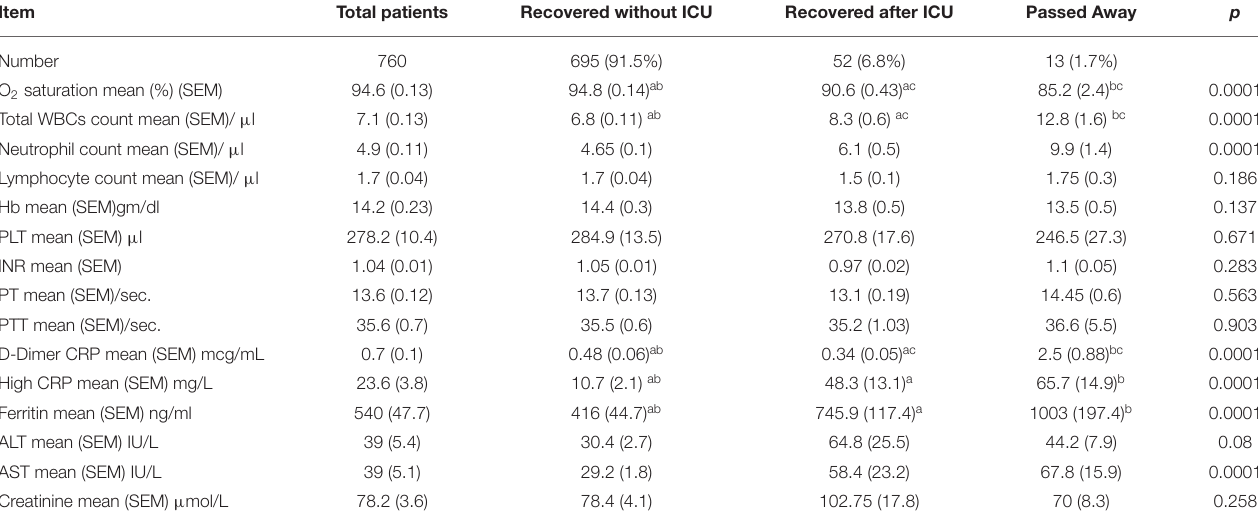
TABLE 2 | Laboratory characteristic of the studied groups of